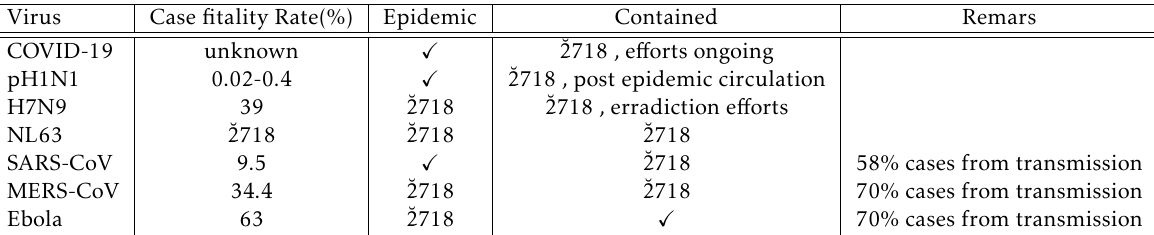
Table 3. Transmission characteristics of recently emerged